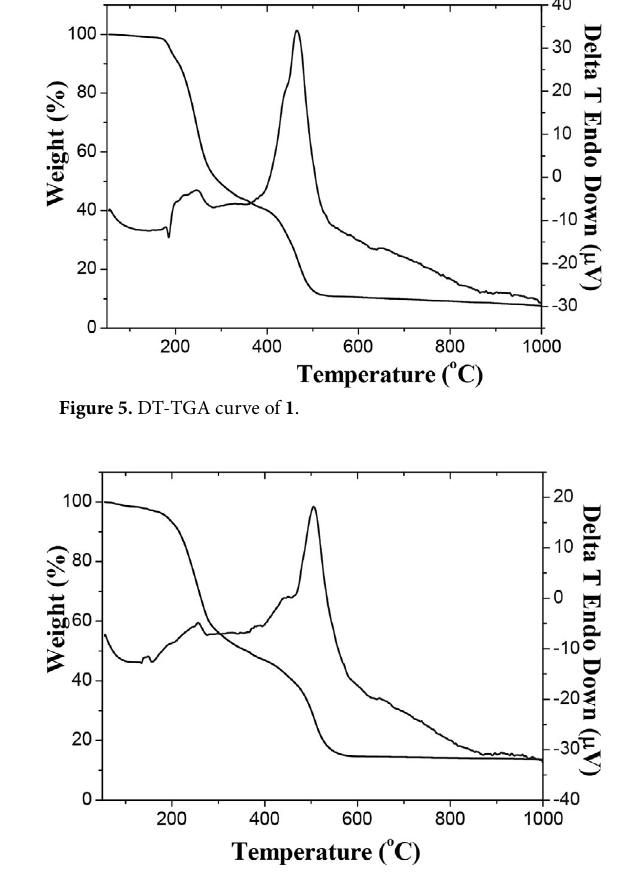
Figure 6. DT-TGA curve of 2 ·2H 2